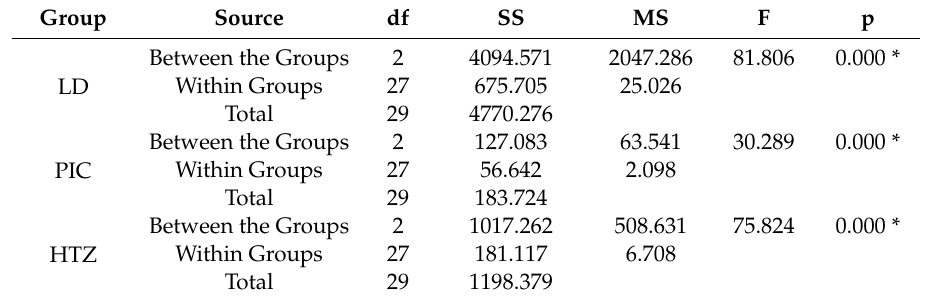
Table 2. One-way analysis of variance of fracture resistance at maximum load between the groups.